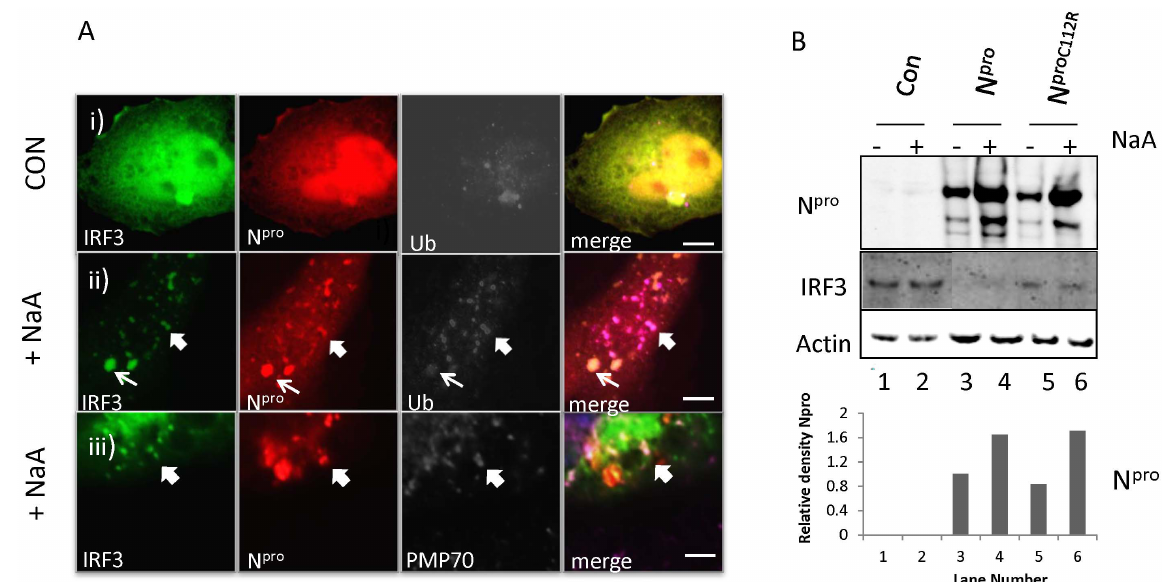
Figure 5. N pro and IRF3 co-distribute to cytoplasmic peroxisomes containing ubiquitin. (A). Cells expressing IRF3 GFP and N pro cherry i) Control cells (CON) were stained for ubiquitin with monoclonal antibody FK2 visualized with anti-mouse Cy5. ii) Cell treated with sodium arsenate ( + NaA) for 60 mins and ubiquitin was stained with monoclonal antibody FK2 and visualized with anti-mouse Cy5. iii) Cells treated with sodium arsenate ( + NaA) for 60 mins and peroxisomes were stained with anti-rabbit PMP70 and visualized with anti- rabbit Cy5. (B). N pro is stabilized and IRF3 degraded following sodium arsenate treatment. Control cells, cells expressing N pro and cells expressing N pro C112R mutant were untreated ( 2 ) or treated with sodium arsenate for 4 hours ( + NaA). Lysates were probed by Western blot for N pro , IRF3 and actin. Actin is shown for equal lane loading and bands were scanned and normalize with actin for N pro levels in treated and untreated cells (bottom graph).